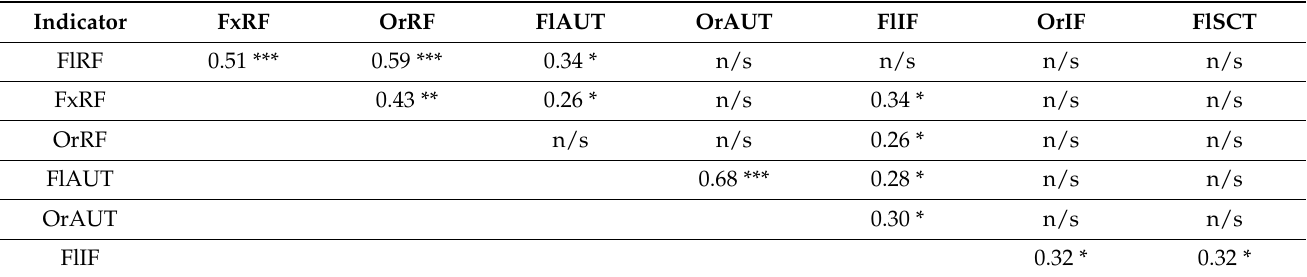
Table 2. The correlation coefficients for the creativity indicators for the schoolchildren.